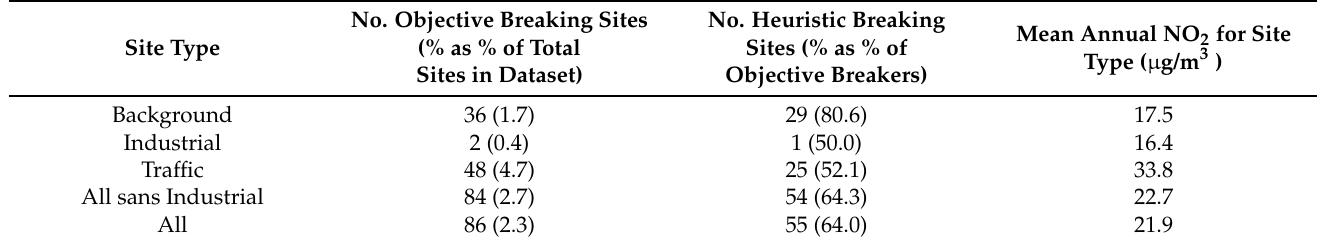
Table 5. A table which examines how many objective breaking sites (sites with >18 exceedances of 200 µ g/m 3 ) are also heuristic breaking sites (having at least one objective breaking year with an annual mean < µ g/m 3 ), as a function of site type for the EU